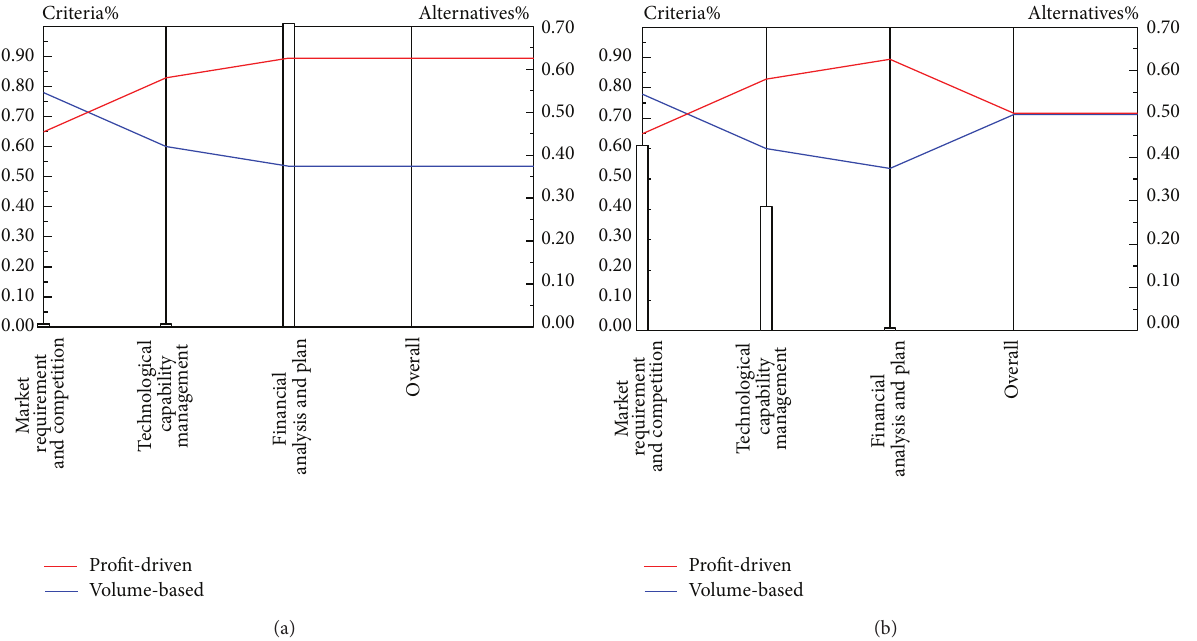
Figure 5: Sensitivity analysis with respect to technological capability